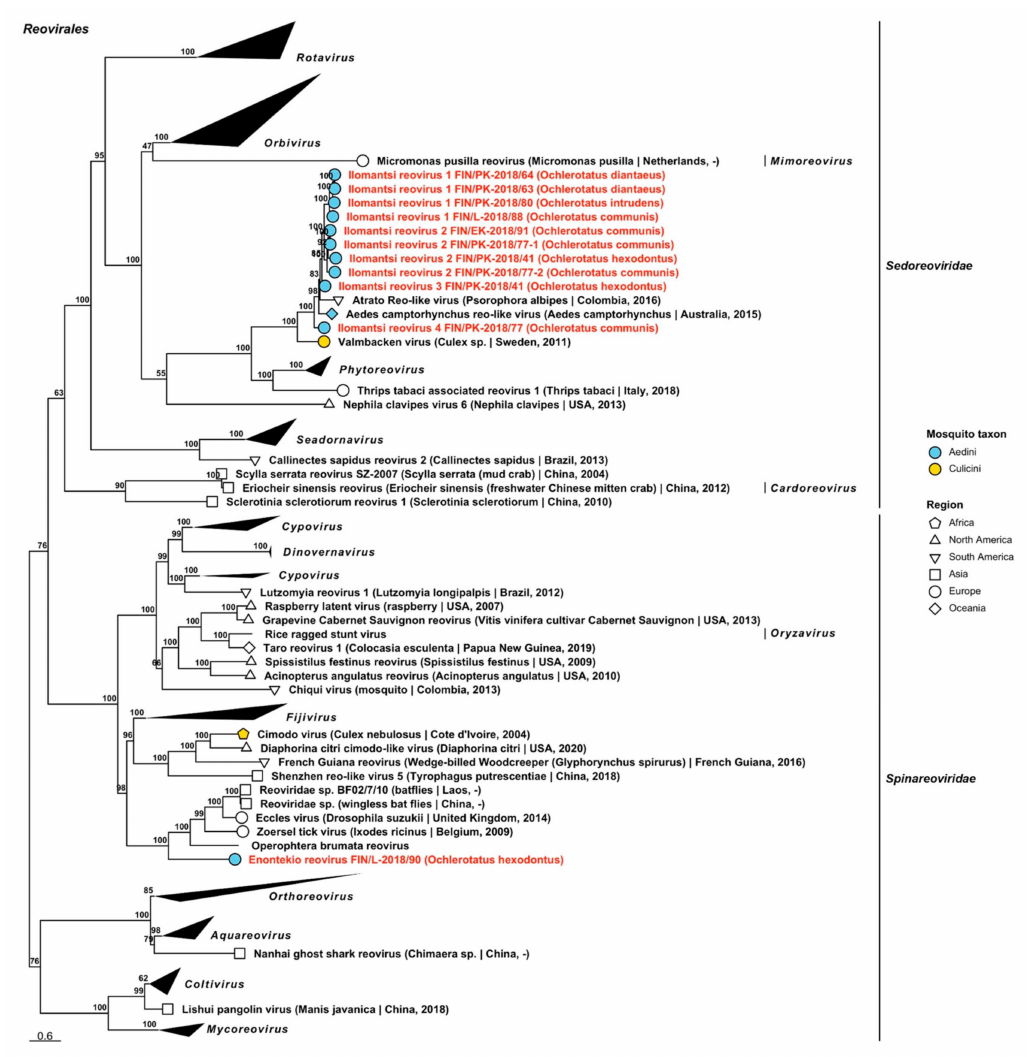
Figure 20. Maximum likelihood tree of Reovirales . Tentative novel viruses are displayed in red and the mosquito species from which they were derived are in parentheses. Sequences from GenBank are black and display the following information after the virus or species name: “(sampled organ- ism(s)|collection country, collection year)”. Tip colours represent the tribe of mosquito from which viruses were obtained. Tip shape represents the continent or region from which the specimens were collected. Trees were constructed from amino acid sequences of virus polymerases >1000 nt, aligned with MAFFT and computed with IQ-TREE2 using ModelFinder and 1000